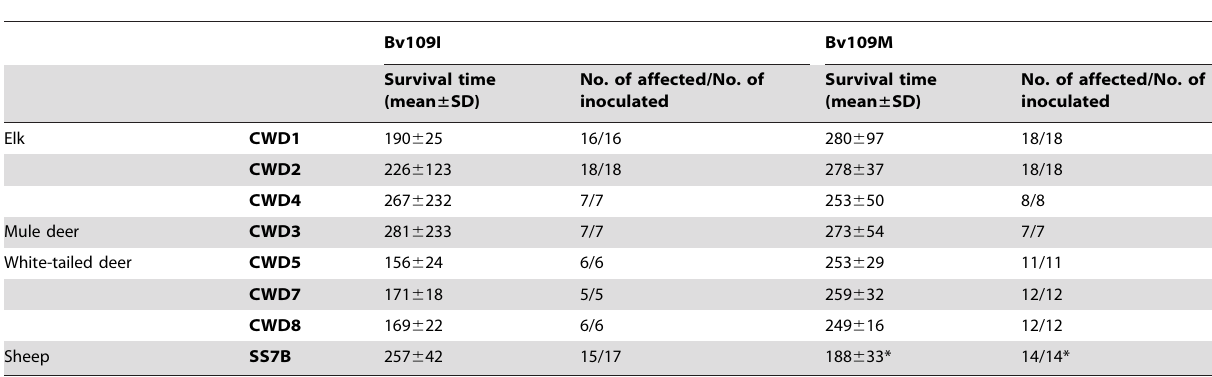
Table 1. Survival times of Bv109I and Bv109M after primary transmission of CWD.